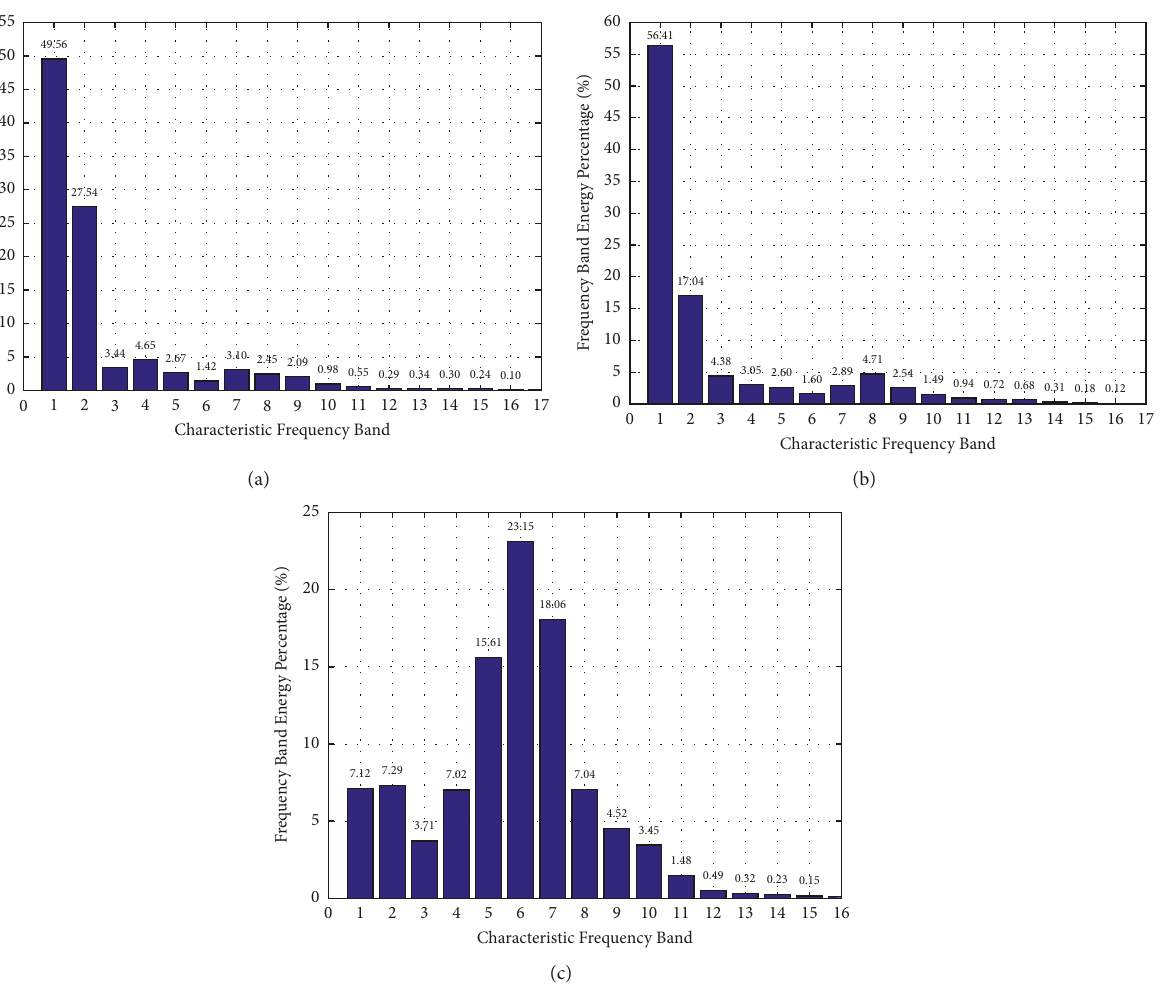
Figure 3: Energy probability distribution of earthquake records at 53DLY (31.3km from the epicentre): (a) east-west; (b) north-south; and (c)